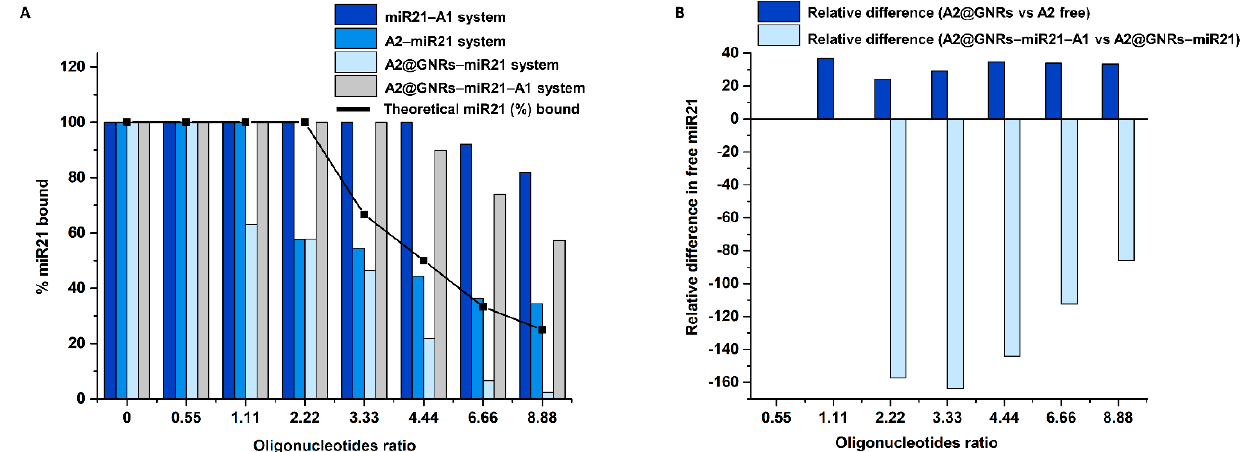
Figure 4. ( A ) Fraction of canonically bound miR21 to A1 and/or A2 as a function of the nominal concentration of miR21 added into various binary or ternary incubates studied, ( B ) Relative differ- ences in the levels of free miR21 detected by CGE as a function of the nominal concentration of miR21 added, demonstrating the influence of GNRs and A1 on the interaction profiles of various binary or ternary incubates.